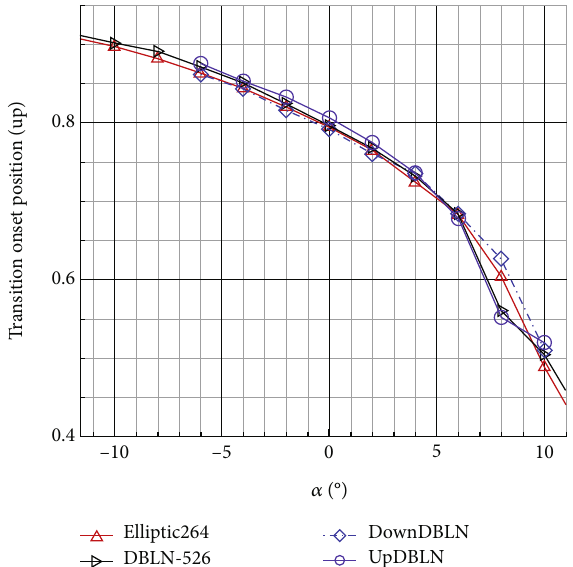
Figure 25: Pressure distribution ( Re = 0 : 8 E 6 , α = 2 ° ).